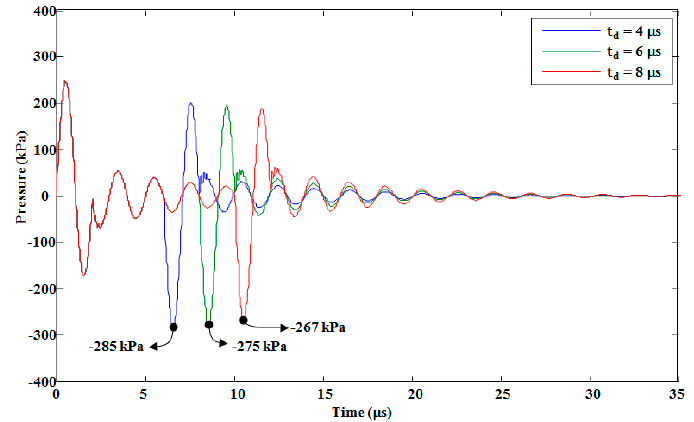
Figure 16. Effect of changing the duration time of the trapezoidal voltage waveform on the pressure in the pressure chamber.